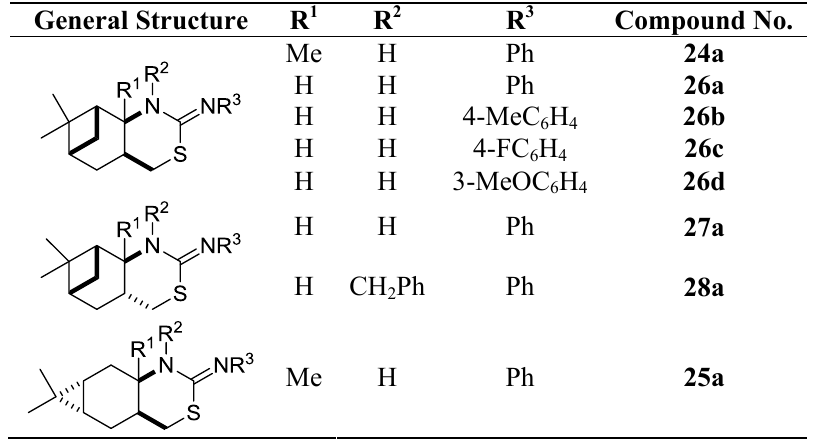
Table 2. 2-Phenylimono-1,3-thiazines 24 – 28